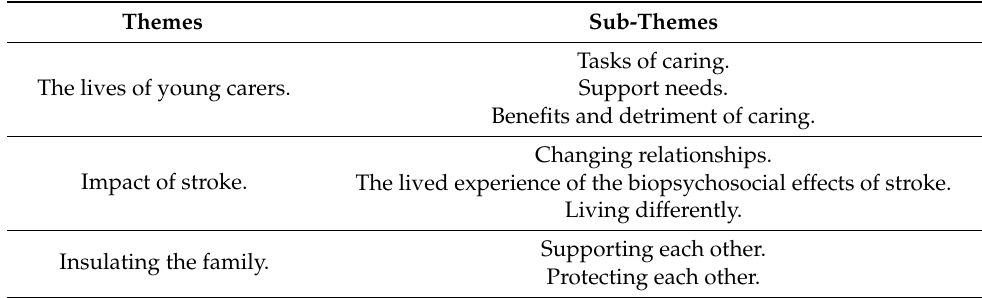
Table 4. Themes and